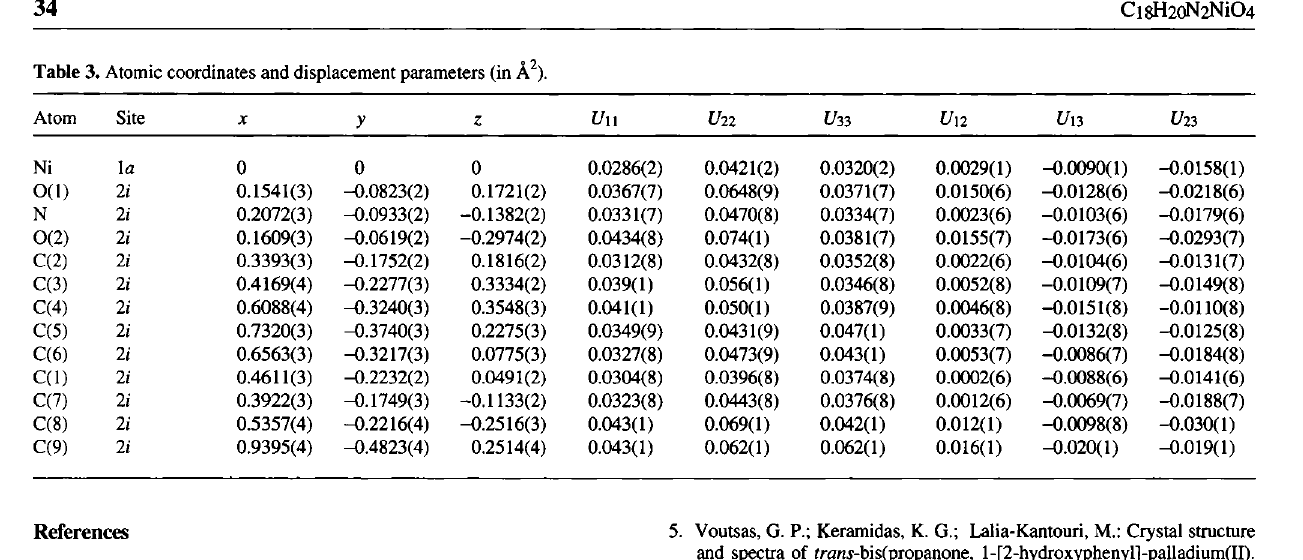
Table 3. Atomic coordinates and displacement parameters (in Â 2